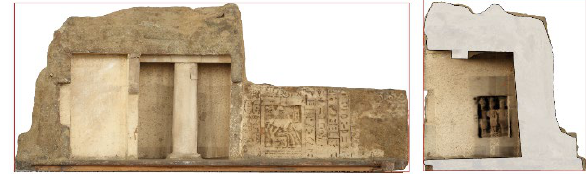
Figure 9. Elevation and cross-section of the surveyed model